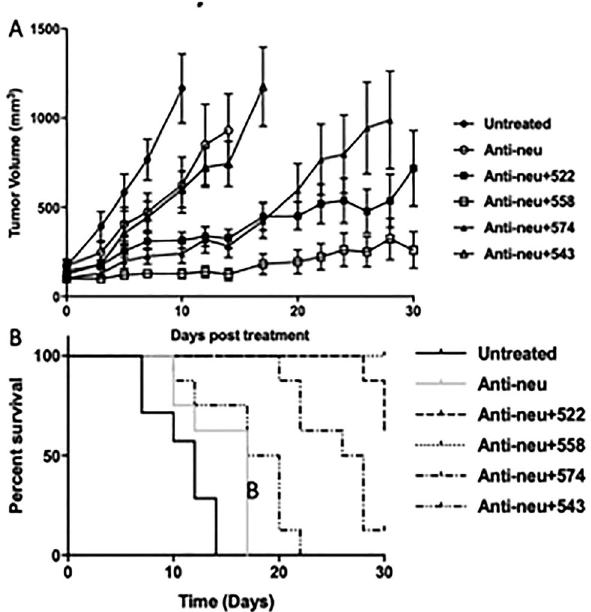
Figure 5. Efficacy study in wild-type Balb/c mice. (A) Tumor volumes plotted against time. Administration of the anti-/neu antibody showed significantly improved tumor growth inhibition in comparison to the untreated group. P < 0.0001 for Untreated v/s anti-neu on Day 10. Compounds 522, 558 and 574 performed significantly better in combination with the anti-neu antibody as opposed to the anti-neu antibody alone. P < 0.0001 for anti-neu v/s anti-neu + 522/558/574 on Day 14. P > 0.05 for anti-neu v/s anti-neu + 543 on Day 14. P < 0.01 for anti-neu v/s anti-neu + 558 on Day 30. All statistics were calculated using two-way ANOVA with multiple comparisons. (B) Survival curves of mice from the efficacy study. Data for the untreated control and anti-neu antibody treatment group reprinted (adapted) with permission from 26 . Copyright 2021 American Chemical